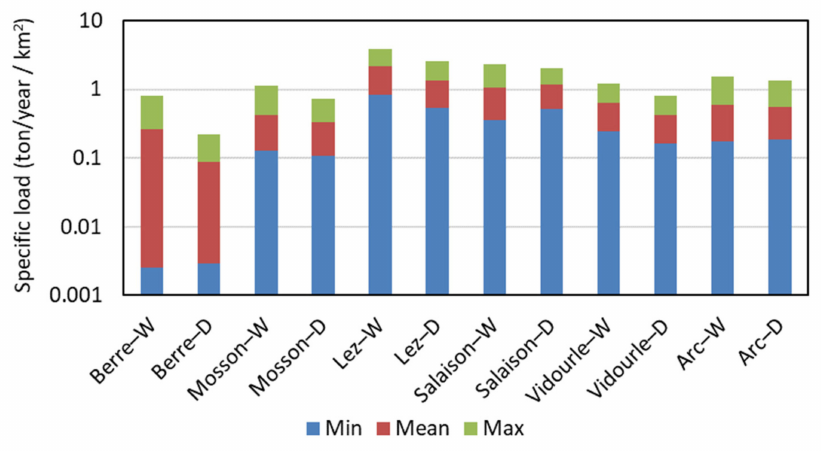
Figure 14. Minimum, average and maximum values of the specific load (ton/year/km 2 ) of total nitrogen calculated for the six watersheds using FWMC and FDRC methods.